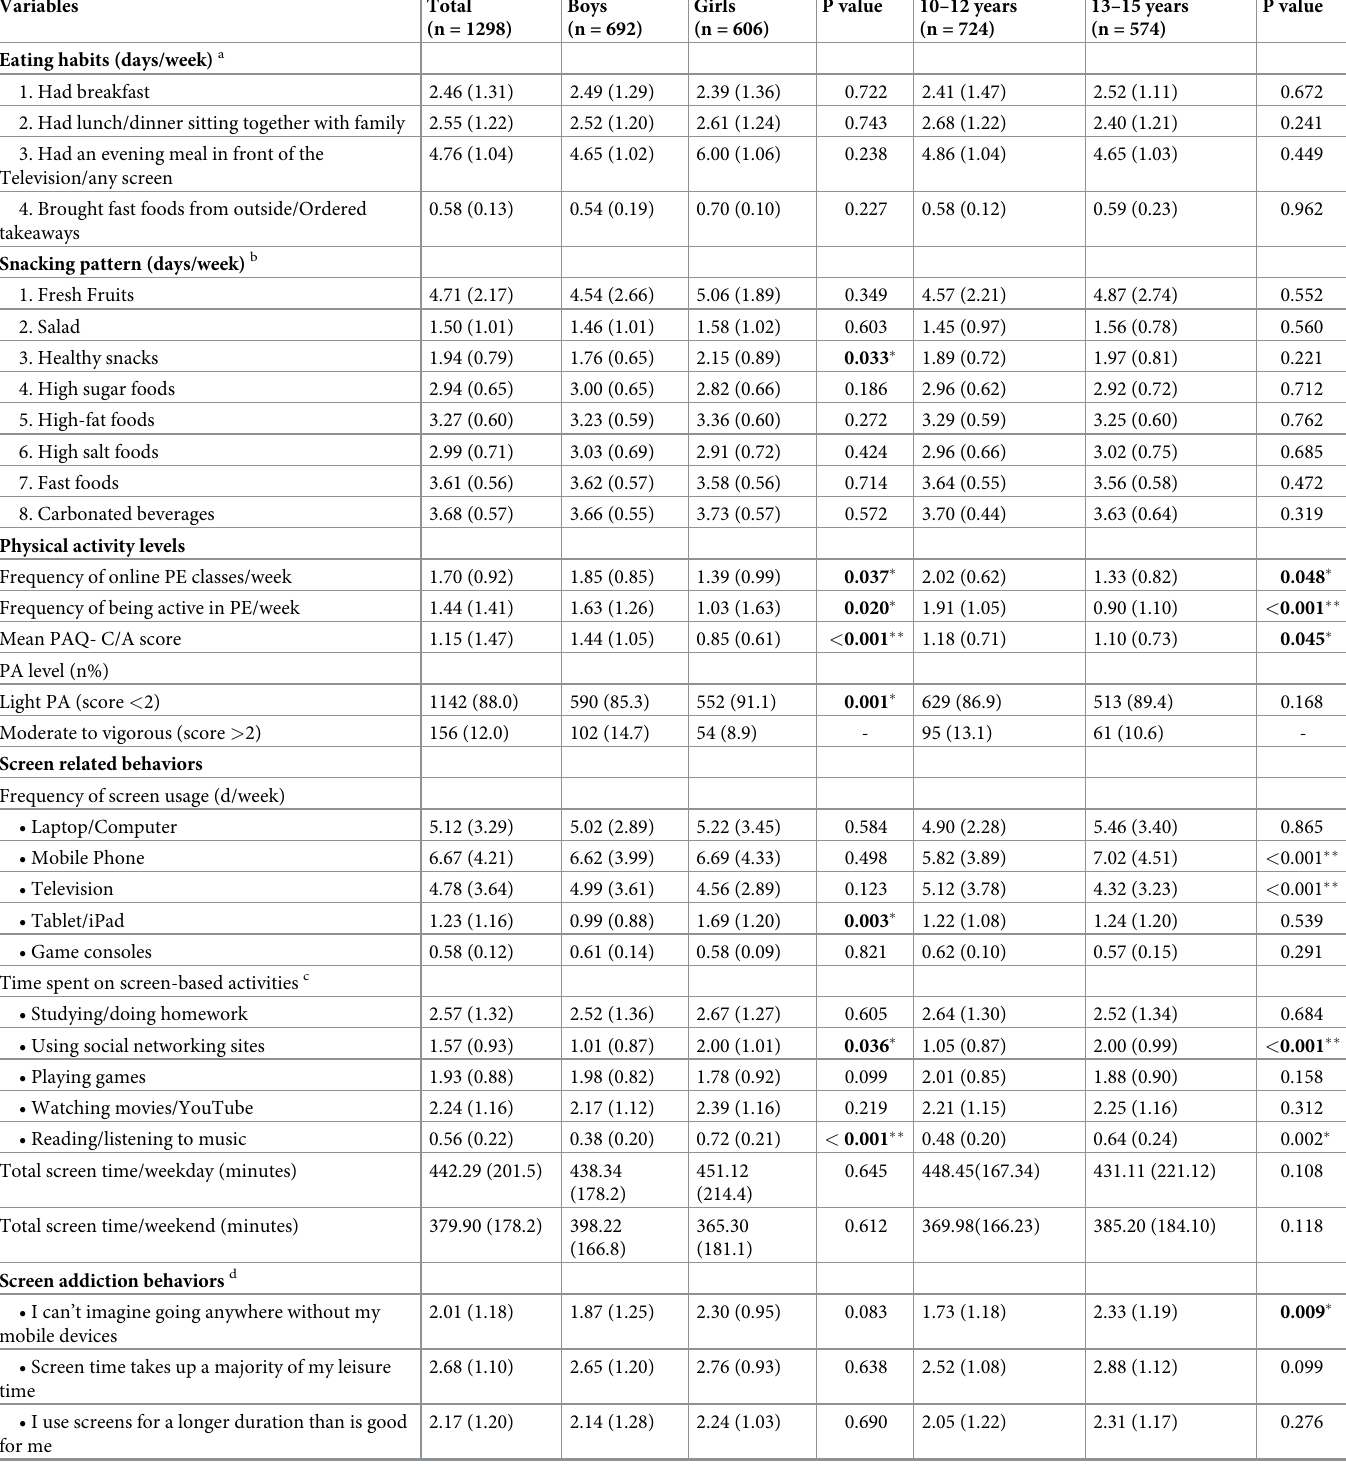
Table 3. Descriptive results of eating habits, screen time, physical activity levels and sleep quality during COVID-19 pandemic of 10–15 years old adolescents, strat- ified by sex and age categories.